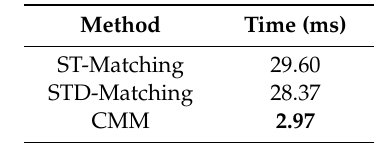
Table 5. Average Running Time per GPS Point on Real GPS Trajectory Dataset.